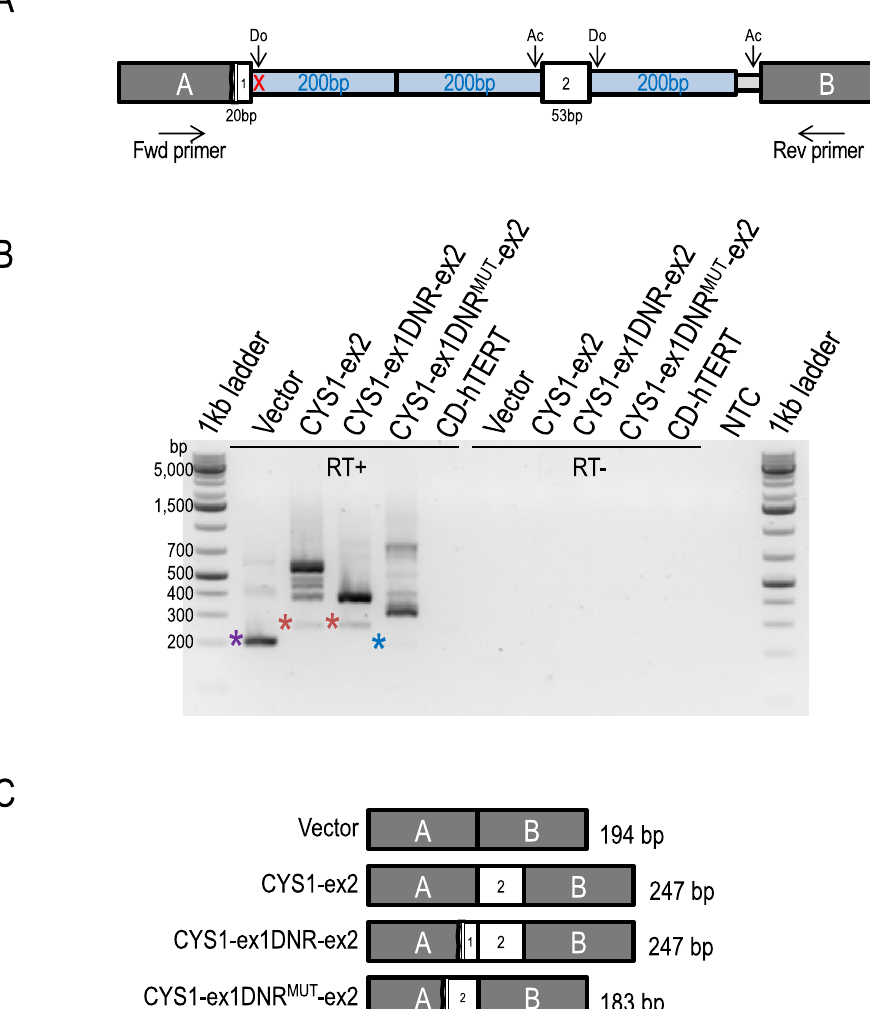
Figure 6. CYS1 variant c.318 + 5G > A caused abnormal splicing of RNA expressed from a transfected minigene in human renal cells. ( A ) Experimental minigene splicing constructs were generated by cloning the following CYS1 sequences between vector exons A and B: 20 bp of CYS1 exon 1 3’ sequence including either the WT or the c.318 + 5G > A patient-derived variant splice donor site; then 200 bp of adjacent intron1 sequence; then CYS1 sequence consisting of the entire CYS1 exon 2 (53 bp) flanked by 200 bp of adjacent CYS1 intronic sequences. Minigene constructs were transfected into human renal collecting duct (CD-hTERT) cells 85 . Normal splice donor (Do) and acceptor (Ac) sites are indicated by arrows. Forward (Fwd) and reverse (Rev) primers corresponding to sequences in vector exons A and B, respectively, were used in RT-PCR. The position of the c.318 + 5G > A patient-derived variant is indicated with a red X. ( B ) RT-PCR reaction products (using Fwd & Rev primer pair) from CD-hTERT RNA following transfection with the indicated plasmids. Amplicons were resolved by agarose gel electrophoresis. RT+, addition of reverse transcriptase; RT-, negative control reactions lacking reverse transcriptase. CD-hTERT indicates template RNA from untransfected cells used as a negative control. NTC, no template control. The vector positive control generated an amplicon of approximately 200 bp, as expected (purple asterisk). CYS1-ex2 and CYS1-ex1DNR-ex2 generated amplicons of the expected 250 bp size (red asterisks). In contrast, the c.318 + 5G > A variant showed loss of the 250 bp amplicon and the appearance of a novel, shorter amplicon (blue asterisk). The identities of the bands marked with asterisks were confirmed by cloning of excised DNA and subsequent restriction and sequence analysis (Supplementary Data). ( C ) RT-PCR amplicon composition and size (bp) corresponding to splicing products generated from transfected minigene constructs amplified using the Fwd and Rev primer pair (shown in A ). Outcomes for the variant construct, assuming an effect of the CYS1 variant on splicing, could not be predicted a priori. The composition of the splicing product shown here is from the actual sequence of the cloned amplicon (see Supplementary Data). Sequences of cloned splice product amplicons from all other constructs corresponded precisely to anticipated